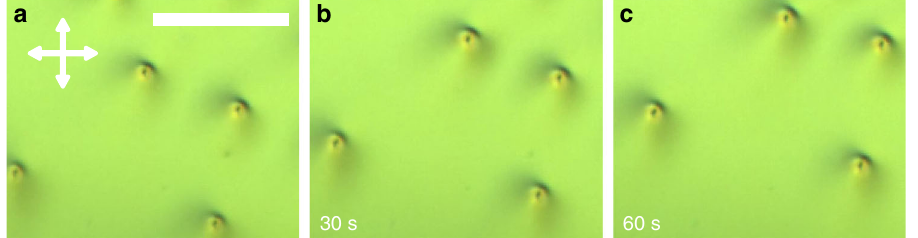
Fig. 8 Collective unidirectional motion of baby skyrmions. a – c POM frames from a POM video. The elapsed time is marked in the bottom – left corners of the images. The orientation of crossed polarizers is shown using white double arrows and the scale bar is 100 µ